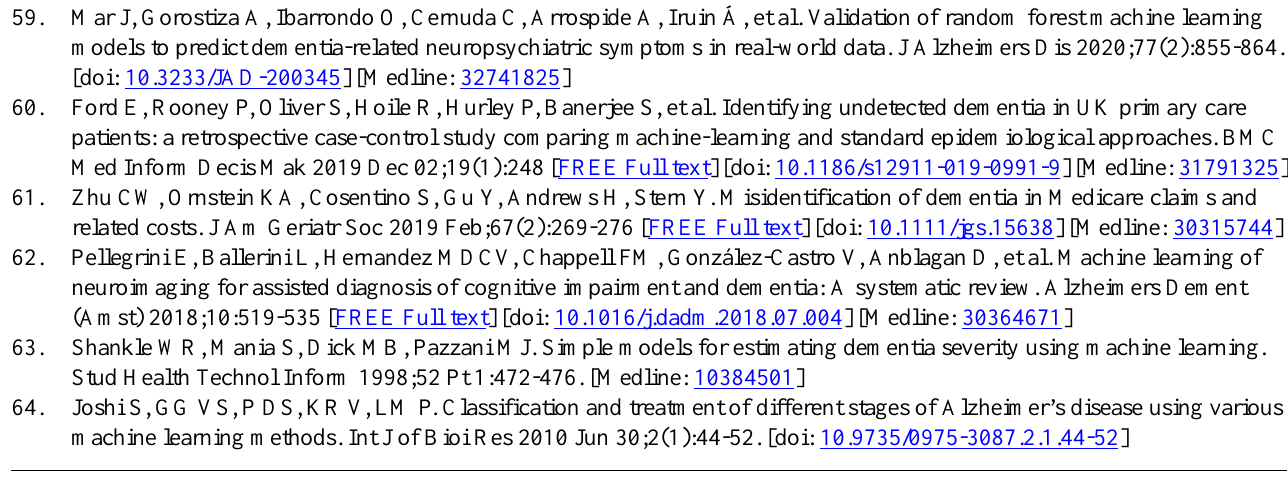
AUROC: area under the receiver operating characteristic curve AUPRC: area under the precision-recall curve FAST: Functional Assessment Staging Test GDS: Global Deterioration